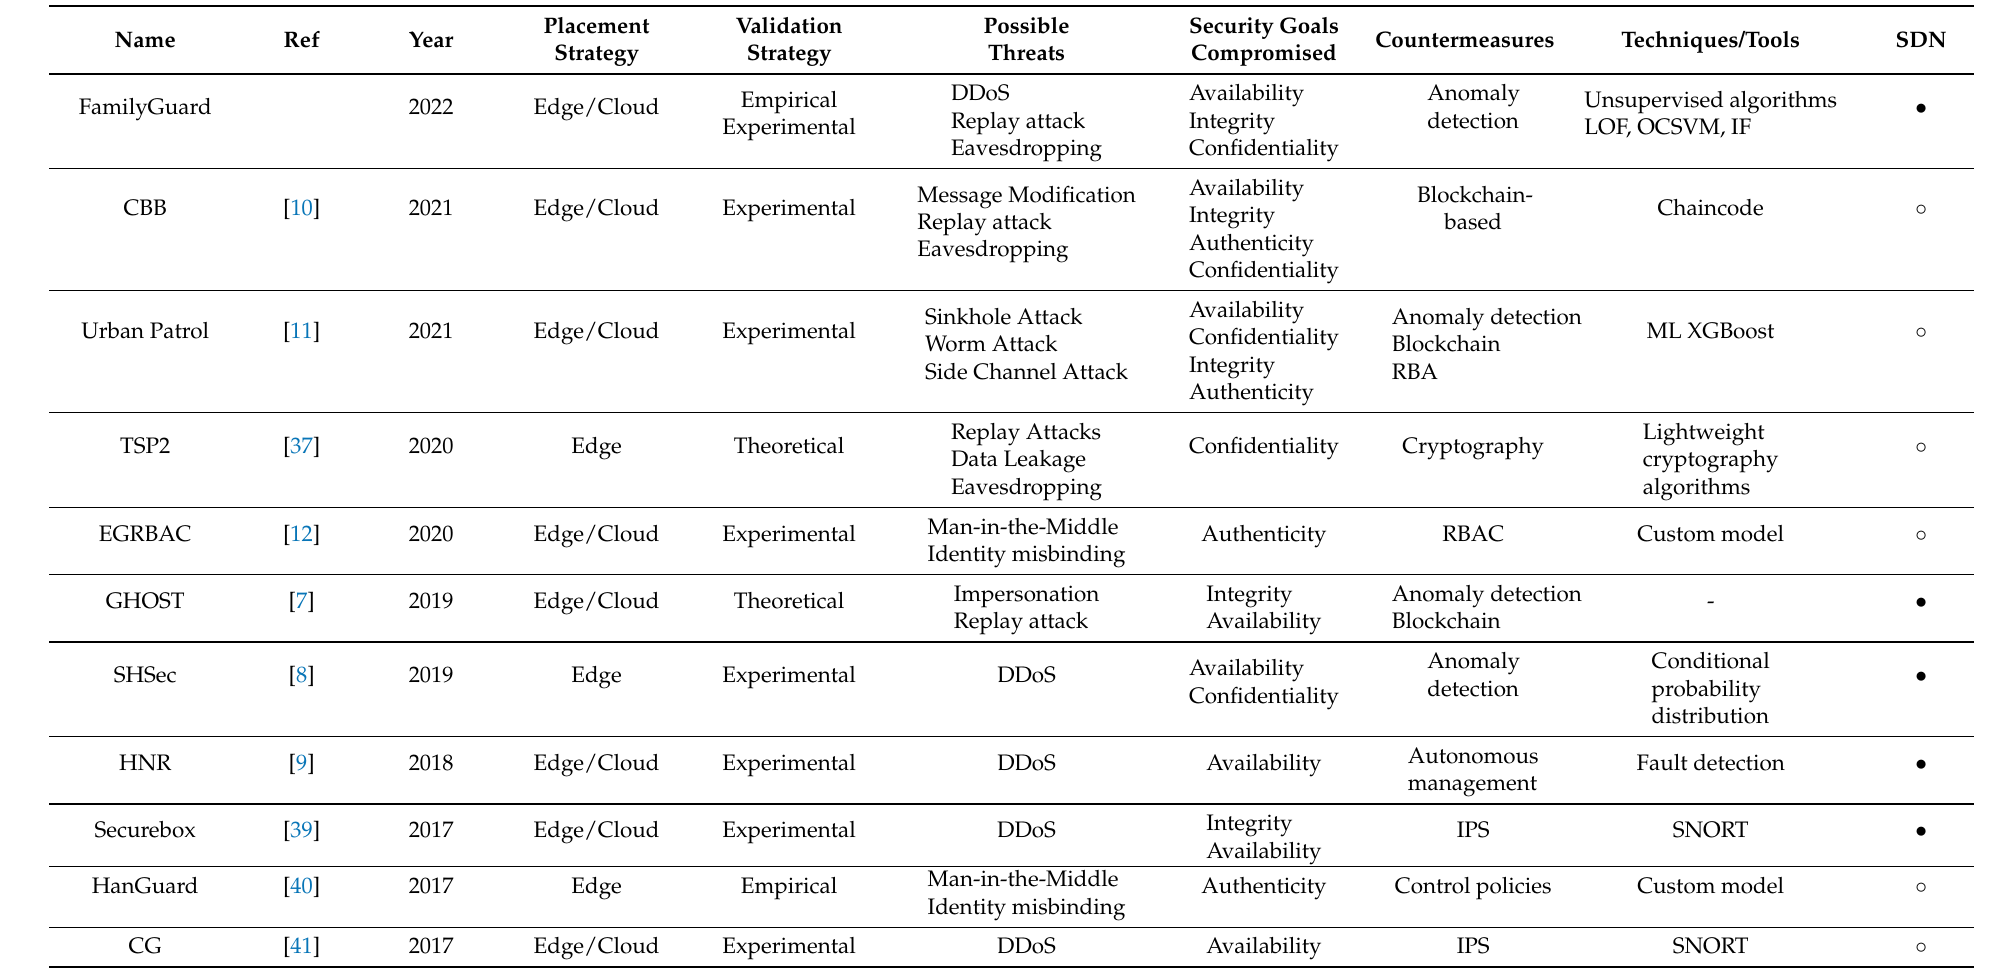
Table 1. Characteristics of